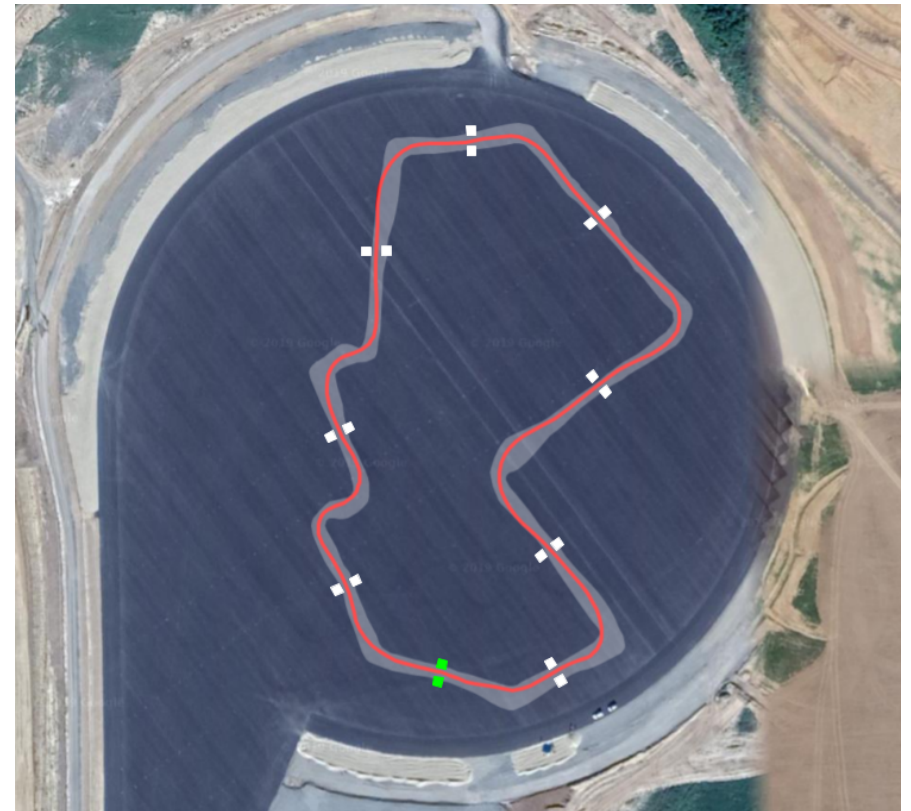
Figure 10. Satellite view of Zala Zone proving ground. Track boundaries and the racing line are shown in red. Gates are shown in white and the starting point in green.